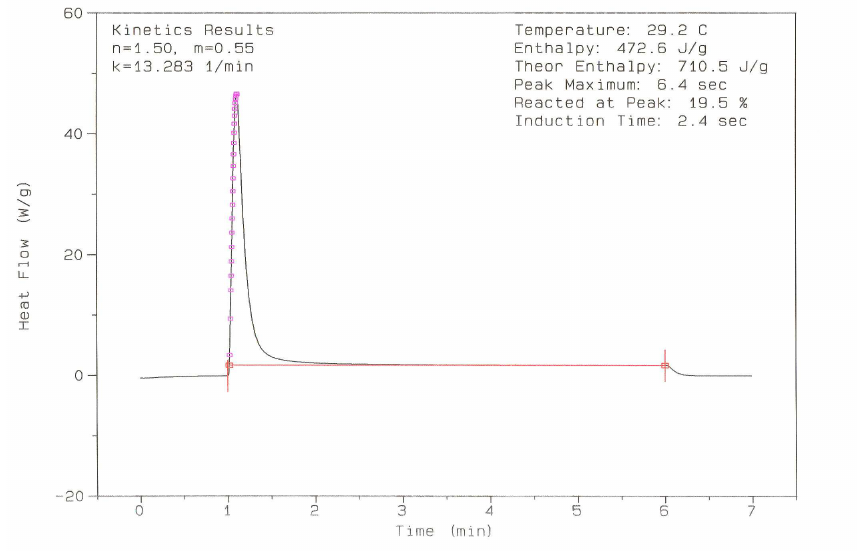
Fig. 4 Typical exotherm plot of the polymerization of EDA photoinitiated by MBDPPO (conc. 3 % w/w), additive triethylamine 3 % w/w at 30 ◦